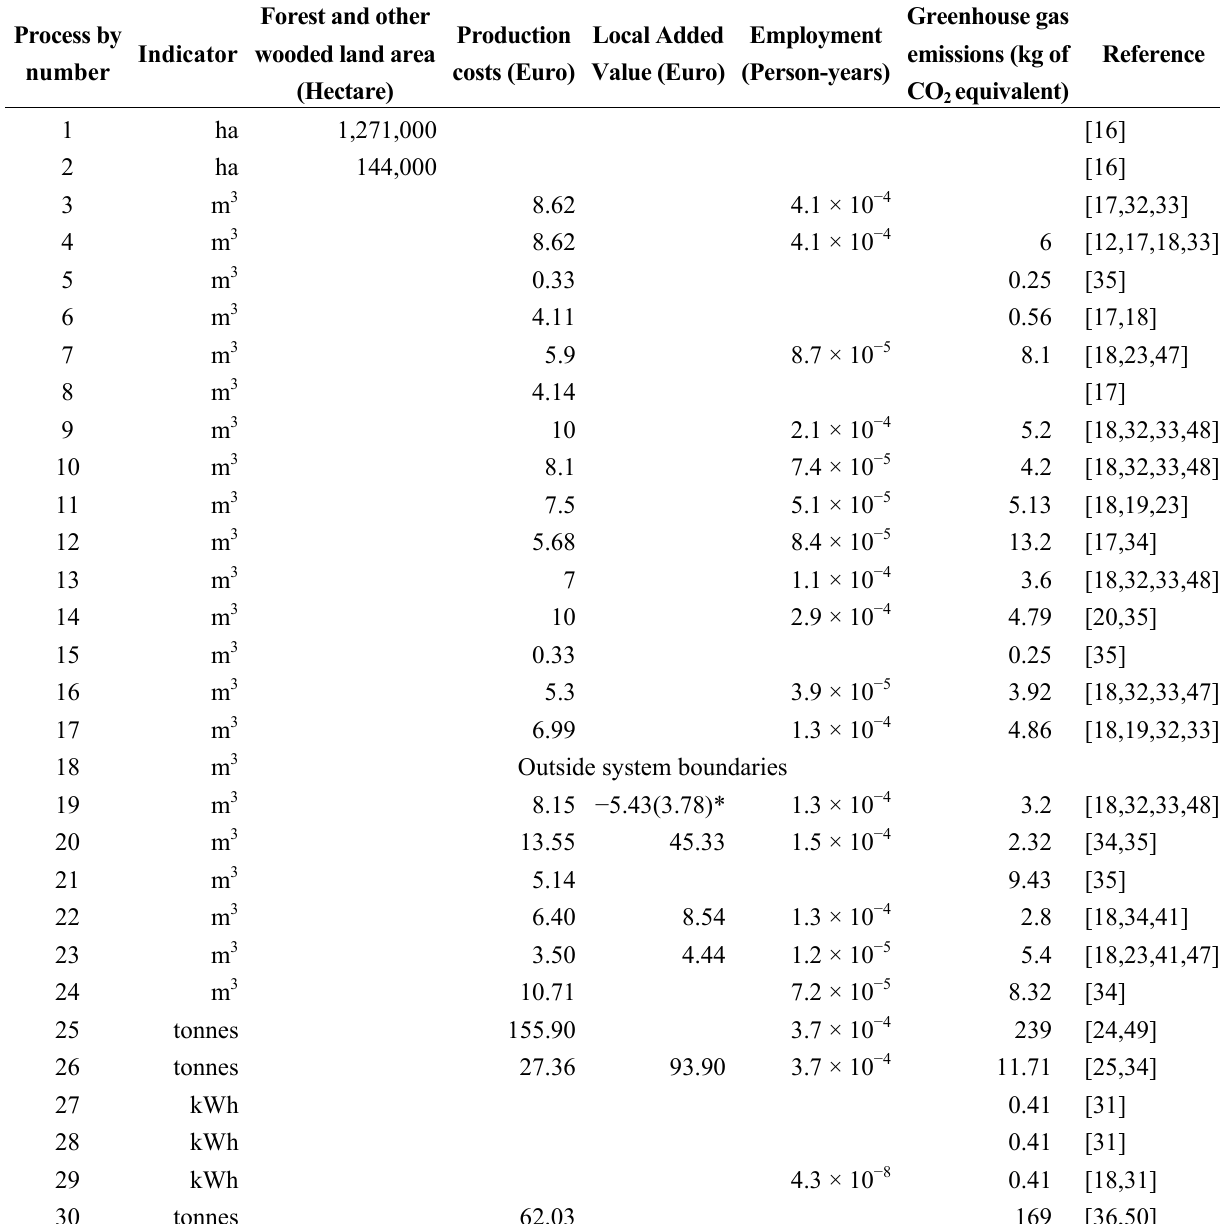
Table A1. Input data for the calculation of the indicators with references to the original sources (databases, scientific literature, official statistics, branch statistics or expert opinion). Indicator data are given per process unit, e.g., in process number 4 “energy wood thinning” production costs are 8.62 €/m 3